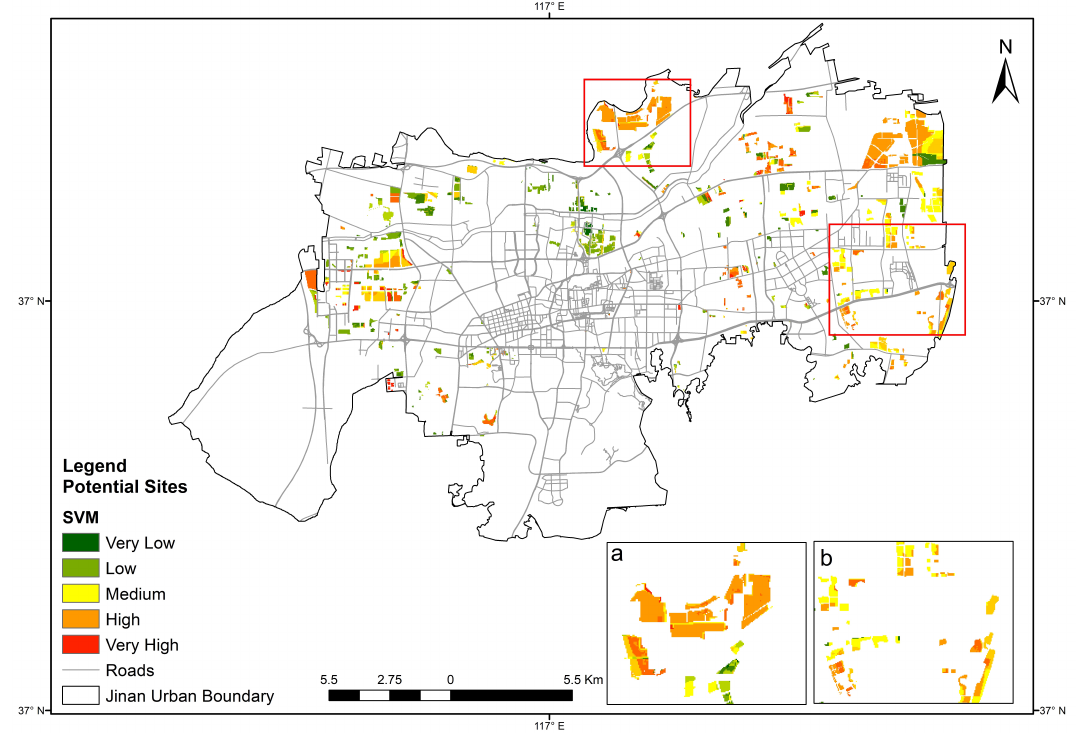
Figure 8. GI development potential sites mapping by SVM model: (bottom right) ( a ) North and ( b ) East of Jinan likely to be converted into